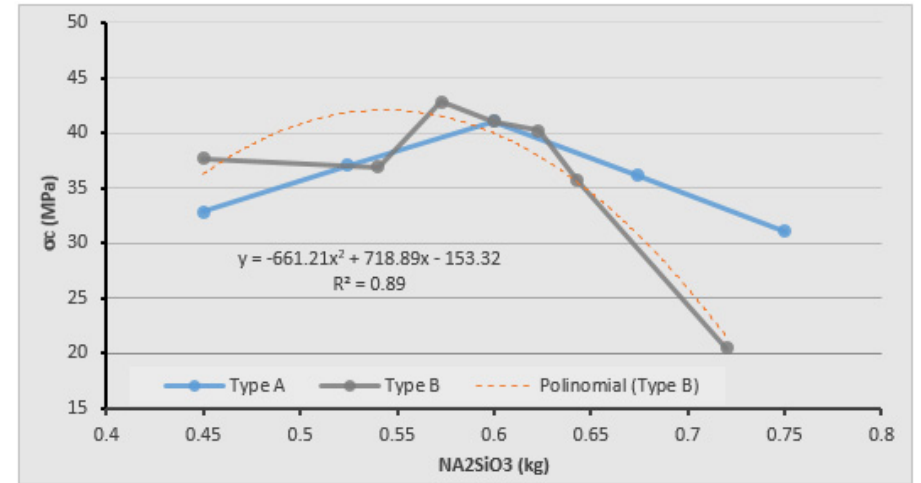
Figure 9. Influence of sodium hydroxide (NaOH) on the compressive strength.